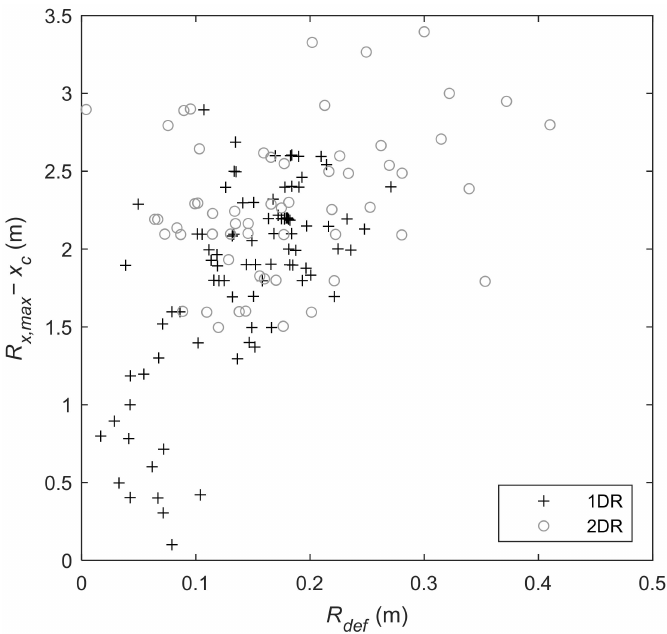
Figure 11. Incursion distance relative to the cross-shore crest location as a function of the freeboard deficit. Black crosses represent data for 1DR and the 2DR data are shown as grey circles. Note that 20 min segments where the entire structure was overwashed such that overtopping events reached the sand beach landward of the revetment were excluded from this analysis.